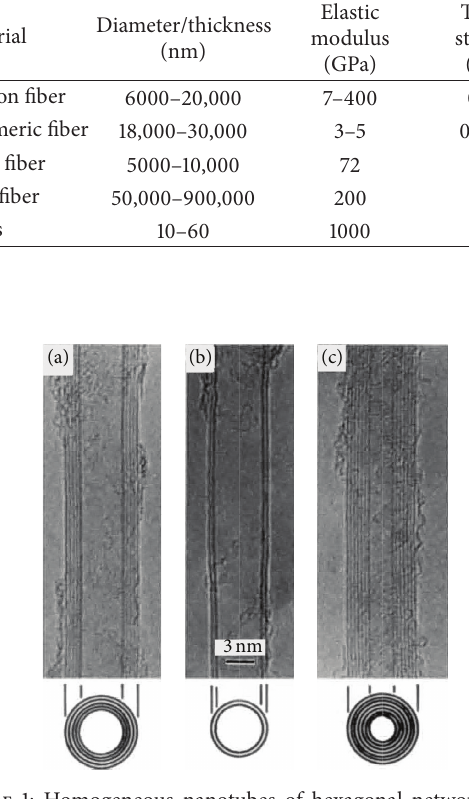
Figure 1: Homogeneous nanotubes of hexagonal network: TEM images (a), (b), and (c) for three multiwalled nanotubes (MWNTs)